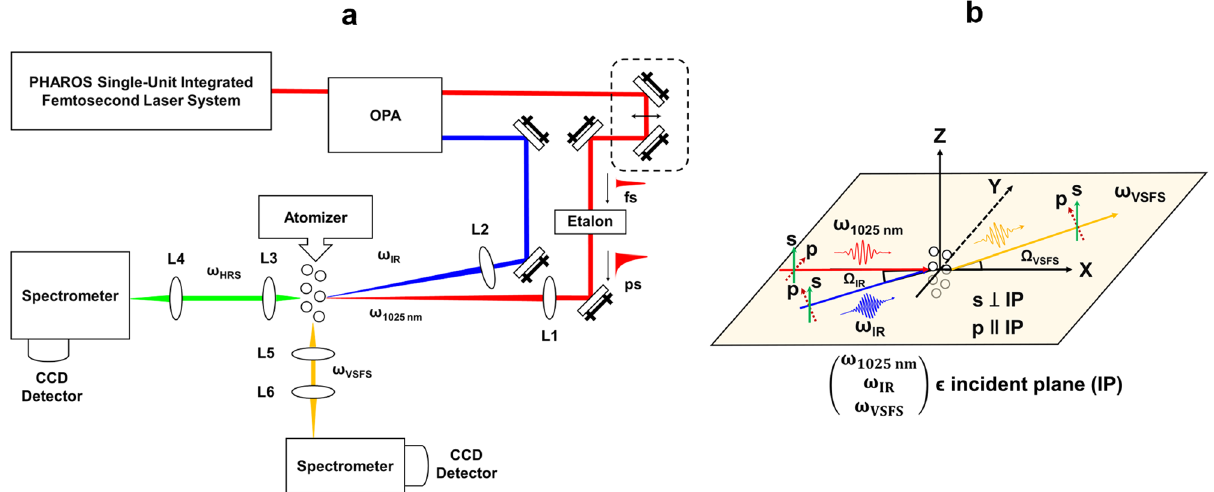
Fig. 1 Schematic diagram for vibrational sum frequency (VSFS) and hyper-Raman scattering (HRS) experiments. a Schematic diagram of both the VSFS and HRS experiments. A spectrally narrow picosecond 1025 nm from an etalon was combined with a broadband OPA-generated IR femtosecond pulse at the aerosol samples to yield sum-frequency and hyper-Raman signals. L1: 1 ” achromatic lens of a 25 cm focal length. L2: 1 ” CaF 2 lens of a 15 cm focal length; L3/L5: 2 ” achromatic lens of a 3.2 cm focal length, and L4/L6: 2 ” achromatic lens of a 7.5 cm focal length. b The narrow picosecond 1025 nm and the broadband IR light were non-collinearly incident on samples at angle of Ω 1025 = 0° and Ω IR = 5° with respect to the X axis. The incident plane and scattering plane were in the X-Y plane, with the Z axis perpendicular to the optical